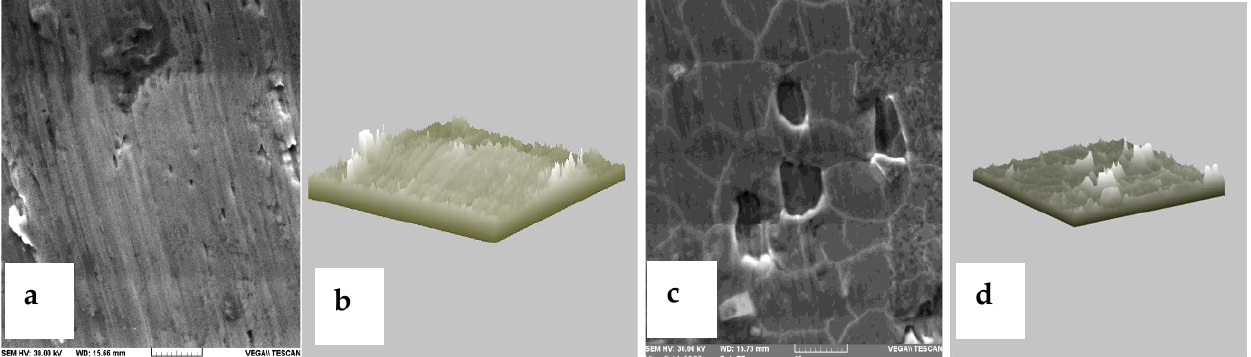
Figure 7. Microstructure of Cr-Co alloy surface before corrosion (( a ) — the surface of the sample is not perfectly smooth; ( b ) — roughness is observed at the edges of the sample) and after corrosion (( c ) — corrosion points on the surface of the sample; ( d ) — roughness distributed over the entire surface of the sample). Figure 8 shows the surface modification of Ni-Cr. It was found that the corrosion process develops over the entire surface, starting from the boundaries of the dendrites in the microstructure of the alloy. The attack on the alloy is deep, and the corrosion points were large and deep, although the electrode potential and the treatment time were the same [15,16].